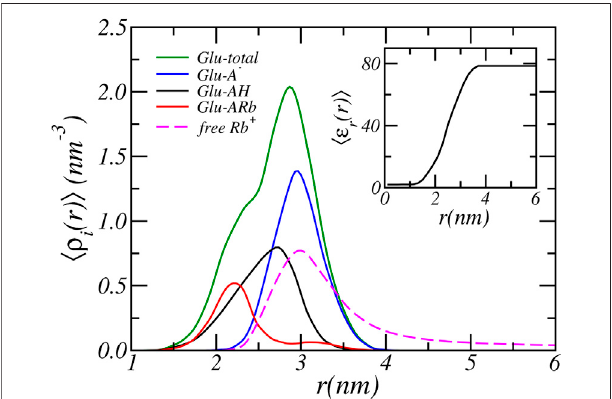
FIGURE 3 | The average degree of protonation, deprotonation and ion- condensation of the glutamic acid residue as function of reservoir pH for a concentration of [RbCl] = 50 mM .